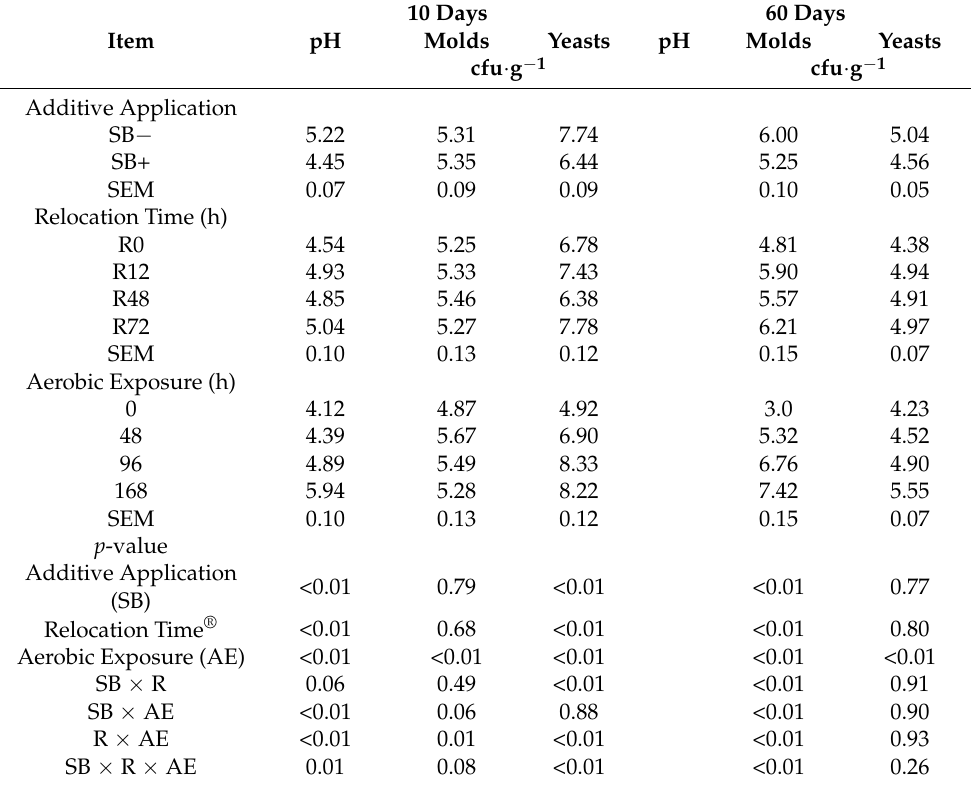
Table 6. The effects of sodium benzoate application (at 2 g · kg − 1 on a fresh matter basis), relocation time, aerobic exposure, and their interactions on the pH and microbiology of sugarcane silage that was stored for 10 or 60 days.